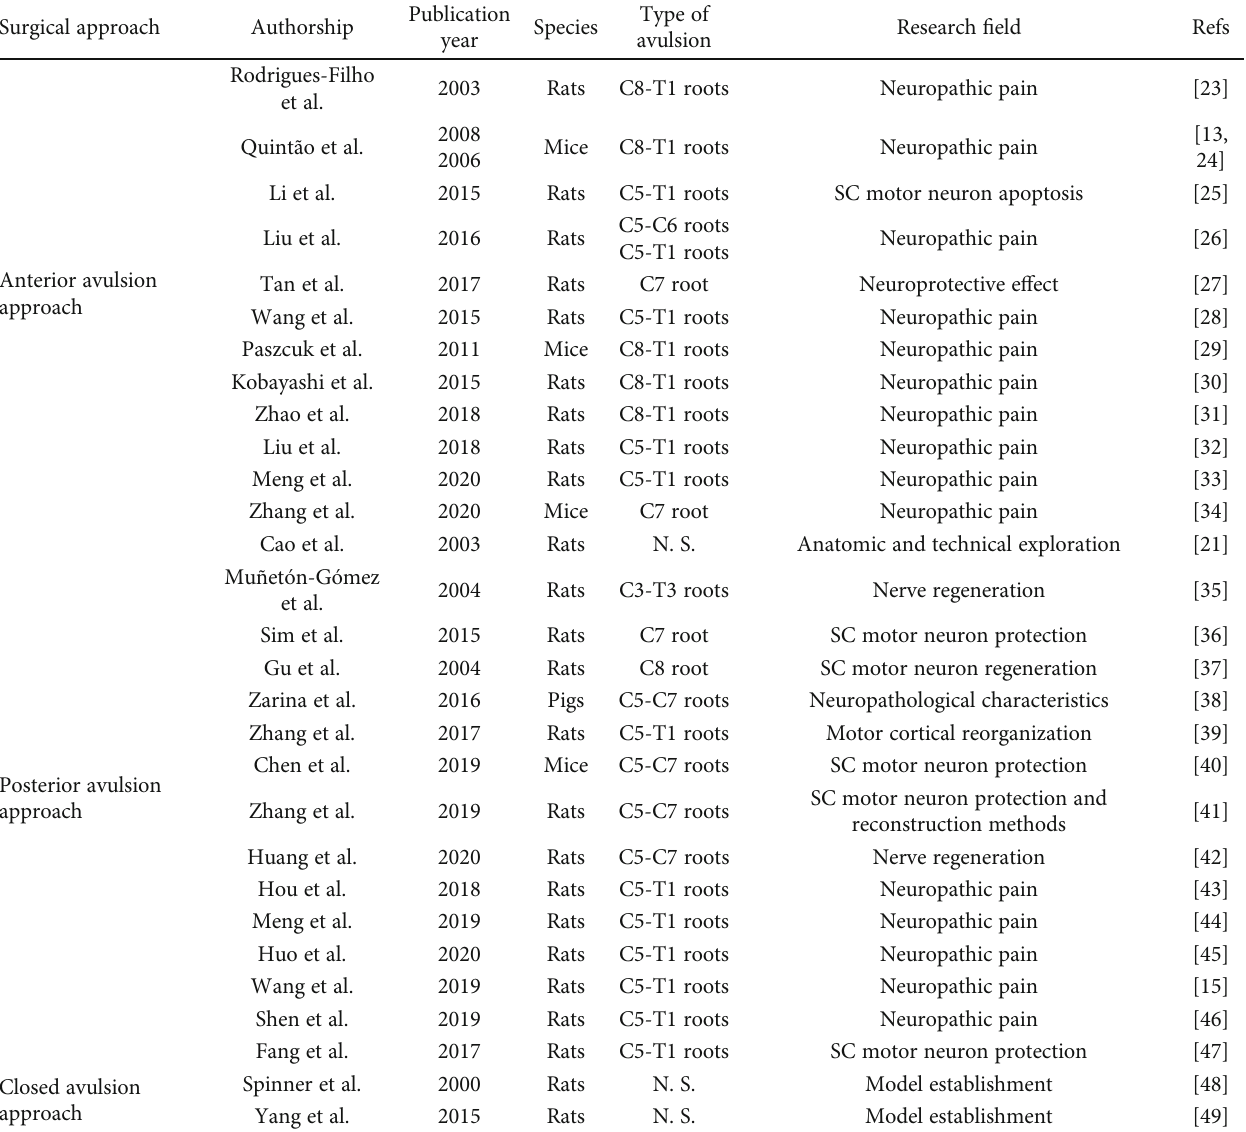
Table 1: Detailed overview of the in vivo models of brachial plexus